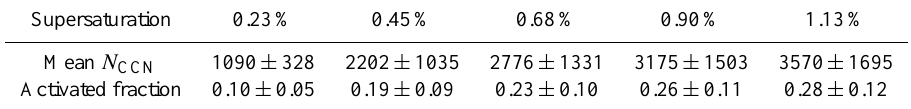
Table 1. Details on the mean measured N CCN values furnished by CCNC for São Paulo from 16 to 31 October 2012. Supersaturation values are estimated considering the air pressure between the operating conditions in São Paulo and that during factory calibration.